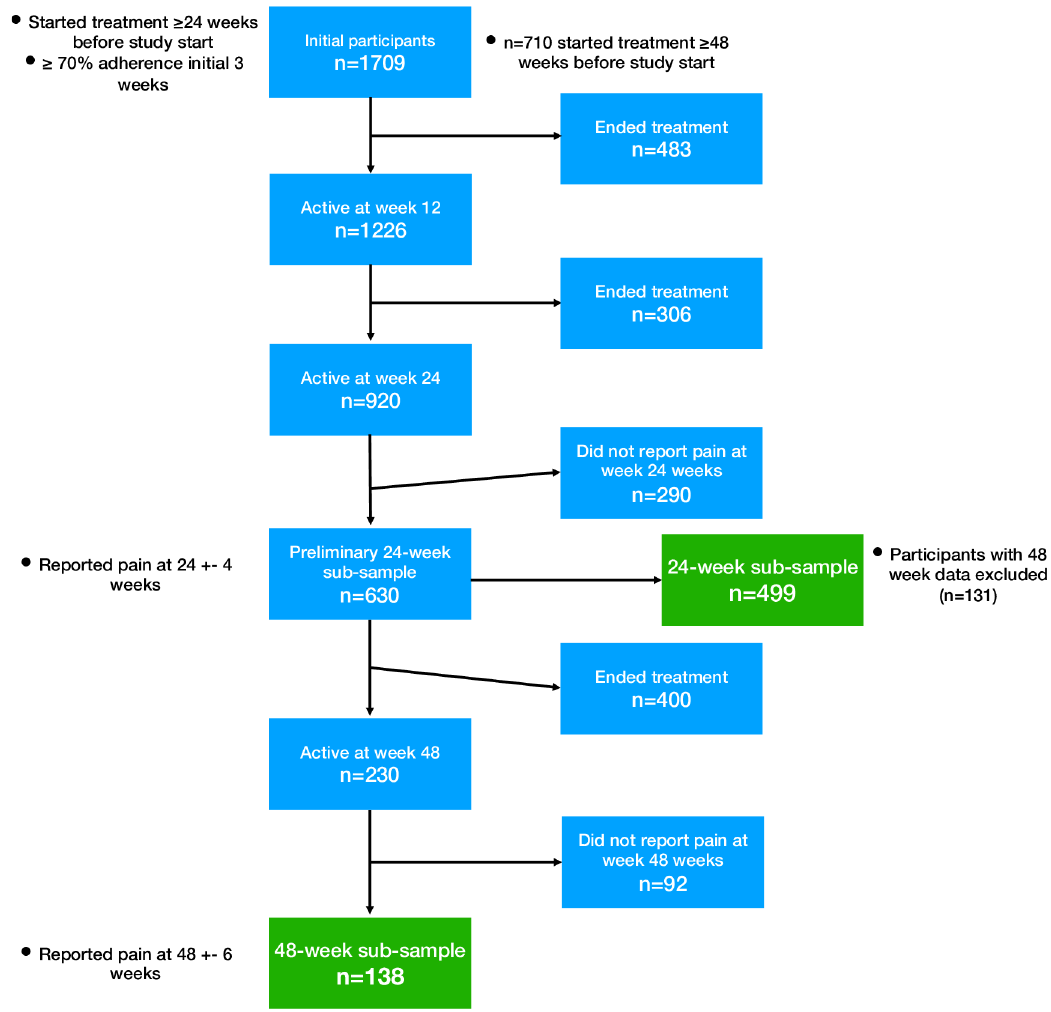
Fig 1. Flowchart describing the disposition of